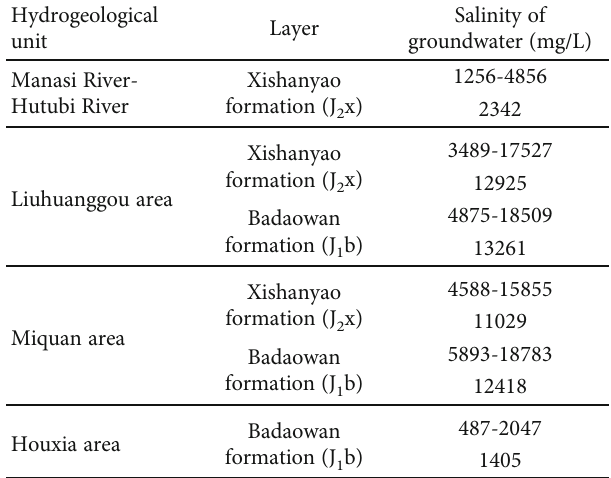
Table 1: TDS distribution of groundwater in coal measures.